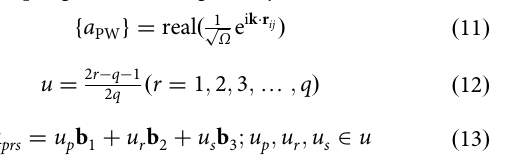
Fig. 2 Several features of the attention mask function M . a a PW q ¼ 4. (crystal structure used here is CaTiO 3 ). b a RBF n 2 ½ 1 ; 16 (cid:5) , cutoff ¼ 8A). c A simple example to show the rotational invariance of a PW reciprocal space. The distance vector r ij and the sampled k -point k i change with the rotation of the whole crystal but their dot product keeps the